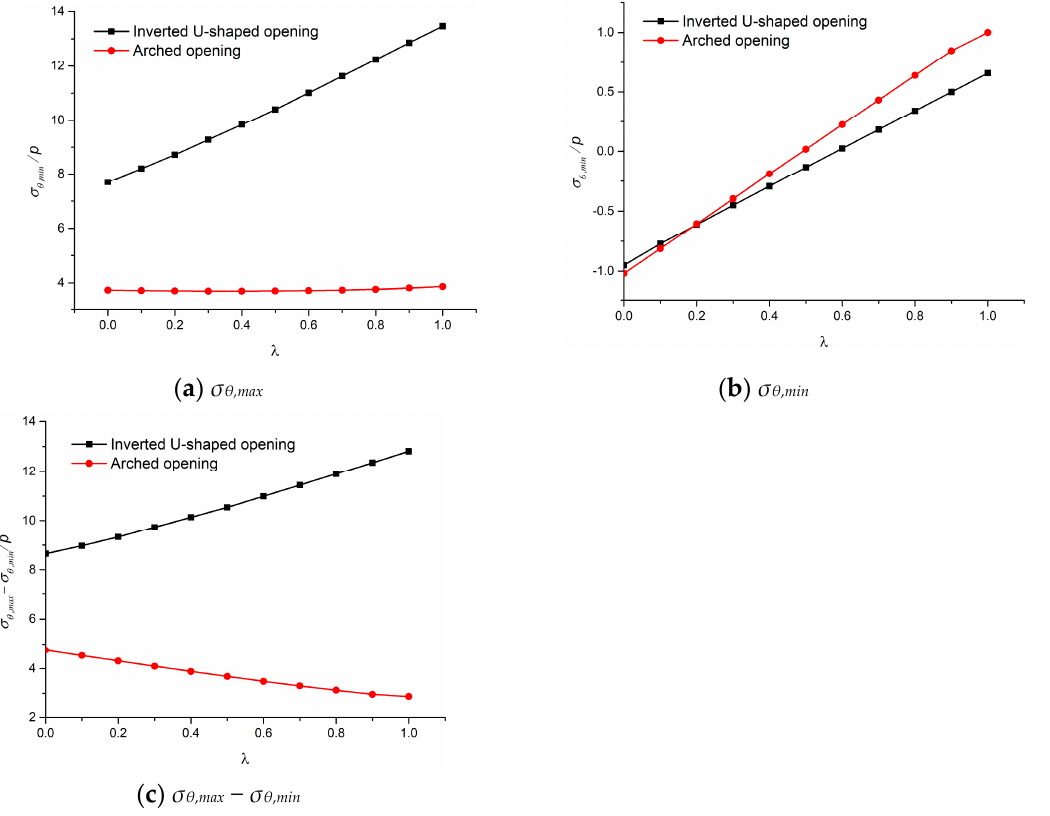
Figure 10. Curves of σ θ , max , σ θ , min and ( σ θ , max − σ θ , min ) versus λ .